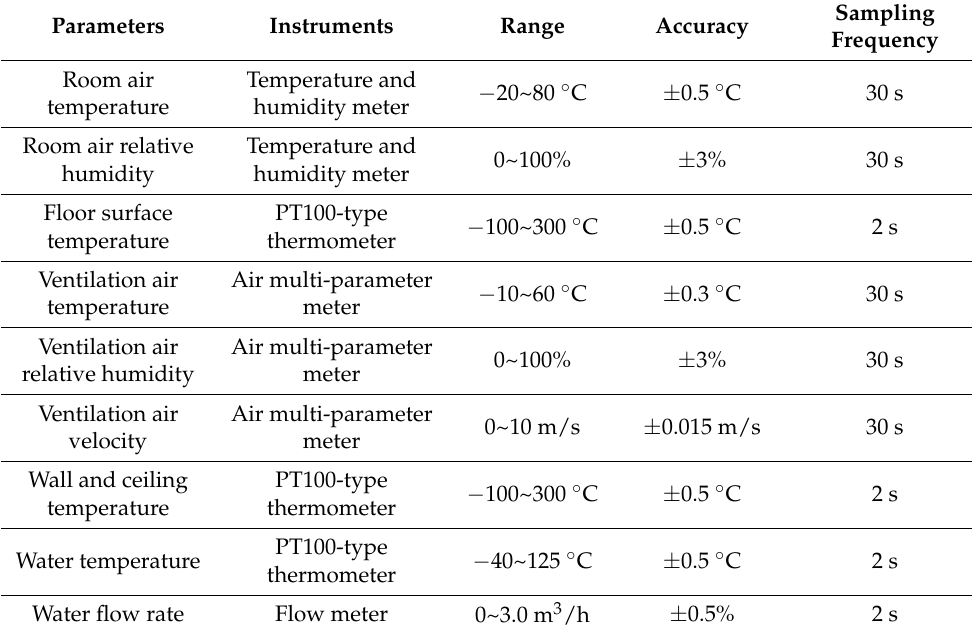
Table 3. Summary of the experimental instrument operating